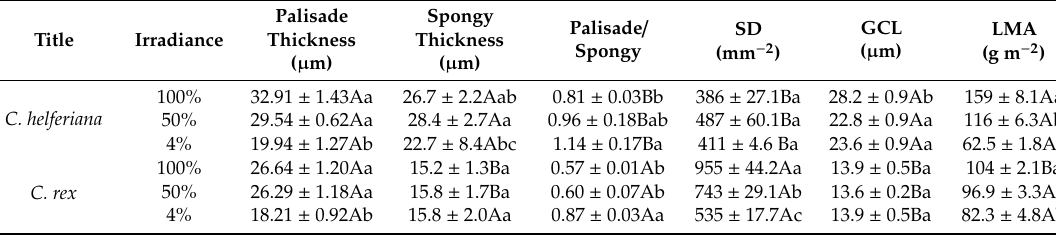
Table 2. Leaf structural traits of C. helferiana and C. rex seedlings grown under three different light conditions. Data are means ± 1SE ( n = 4). Different capital letters indicate significant difference ( p < 0.05) between different species under the same light intensity, and different lowercase letters indicate significant difference ( p < 0.05) between different growth light conditions within the species. SD, stomatal density; GCL, guard cell length; LMA, leaf mass per area.